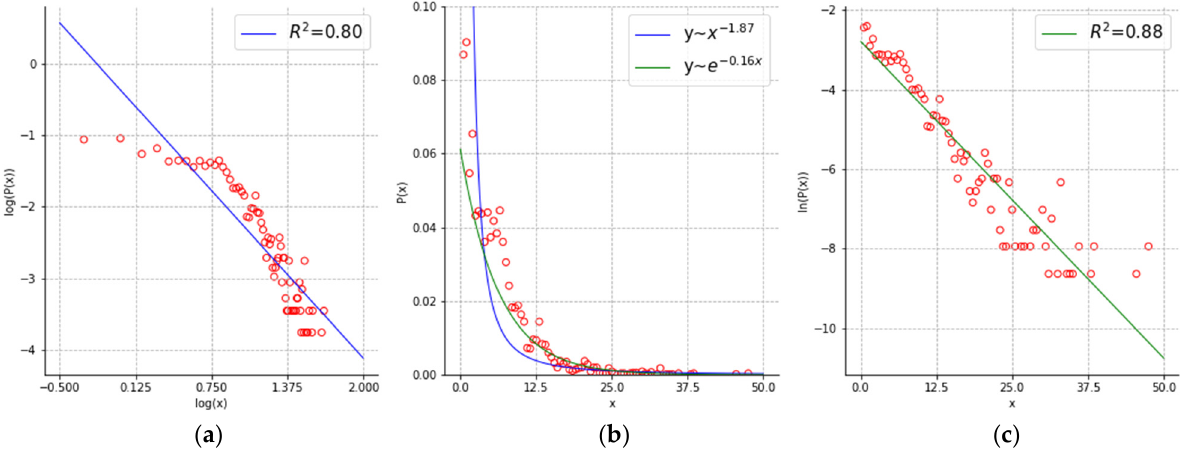
Figure 3. Displacement distribution: ( a ) the relationship between log ( P ) and log ( x ); ( b ) fitting using a power-law function and an exponential function; and ( c ) the relationship between ln ( P ) and x . We calculate the probability P ( x ) of various displacements x (in kilometers) at each level (from 0 to 50 km in increments of 0.5 km) and plot the probabilities on a coordinate system (red circles). We fit the probabilities separately with a power-law function (blue line) and an exponential function (green line). After using a logarithm to transform these into linear forms, we obtain the coefficients of determination ( R 2 values) for the power-law function (0.80) and the exponential function (0.88). Therefore, in our case, we use the following exponential distribution function to represent the dis- placement-distribution probability density function of Guangzhou: 𝑃(cid:4666)𝑋(cid:4667) = 𝑒 (cid:2879)(cid:2868).(cid:2869)(cid:2874)(cid:2875)(cid:3051)(cid:2879)(cid:2871).(cid:2873)(cid:2875)(cid:2873) .